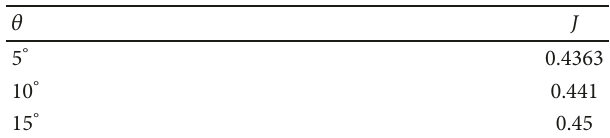
Table 5: Momentum fl ux ratio J with divergence half angle at = 2 . M p